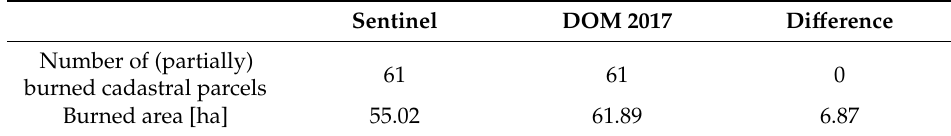
Table 4. Totals of the burned